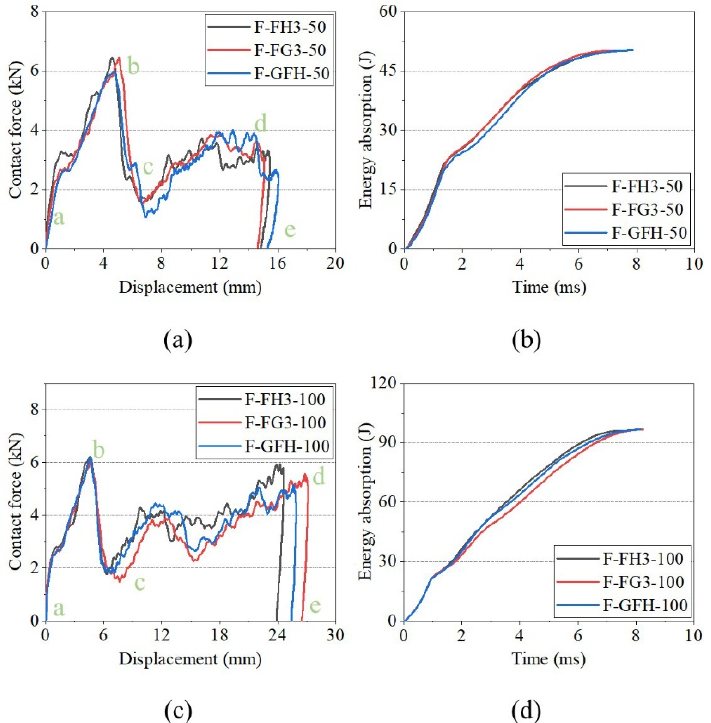
Figure 18. Impact responses of FH3, FG3, and GFH with flat impactor. (a) Contact force–displacement curves of 50J. (b) Energy-absorption curves of 50J. (c) Contact force–displacement curves of 100J. (d) Energy-absorption curves of 100J.